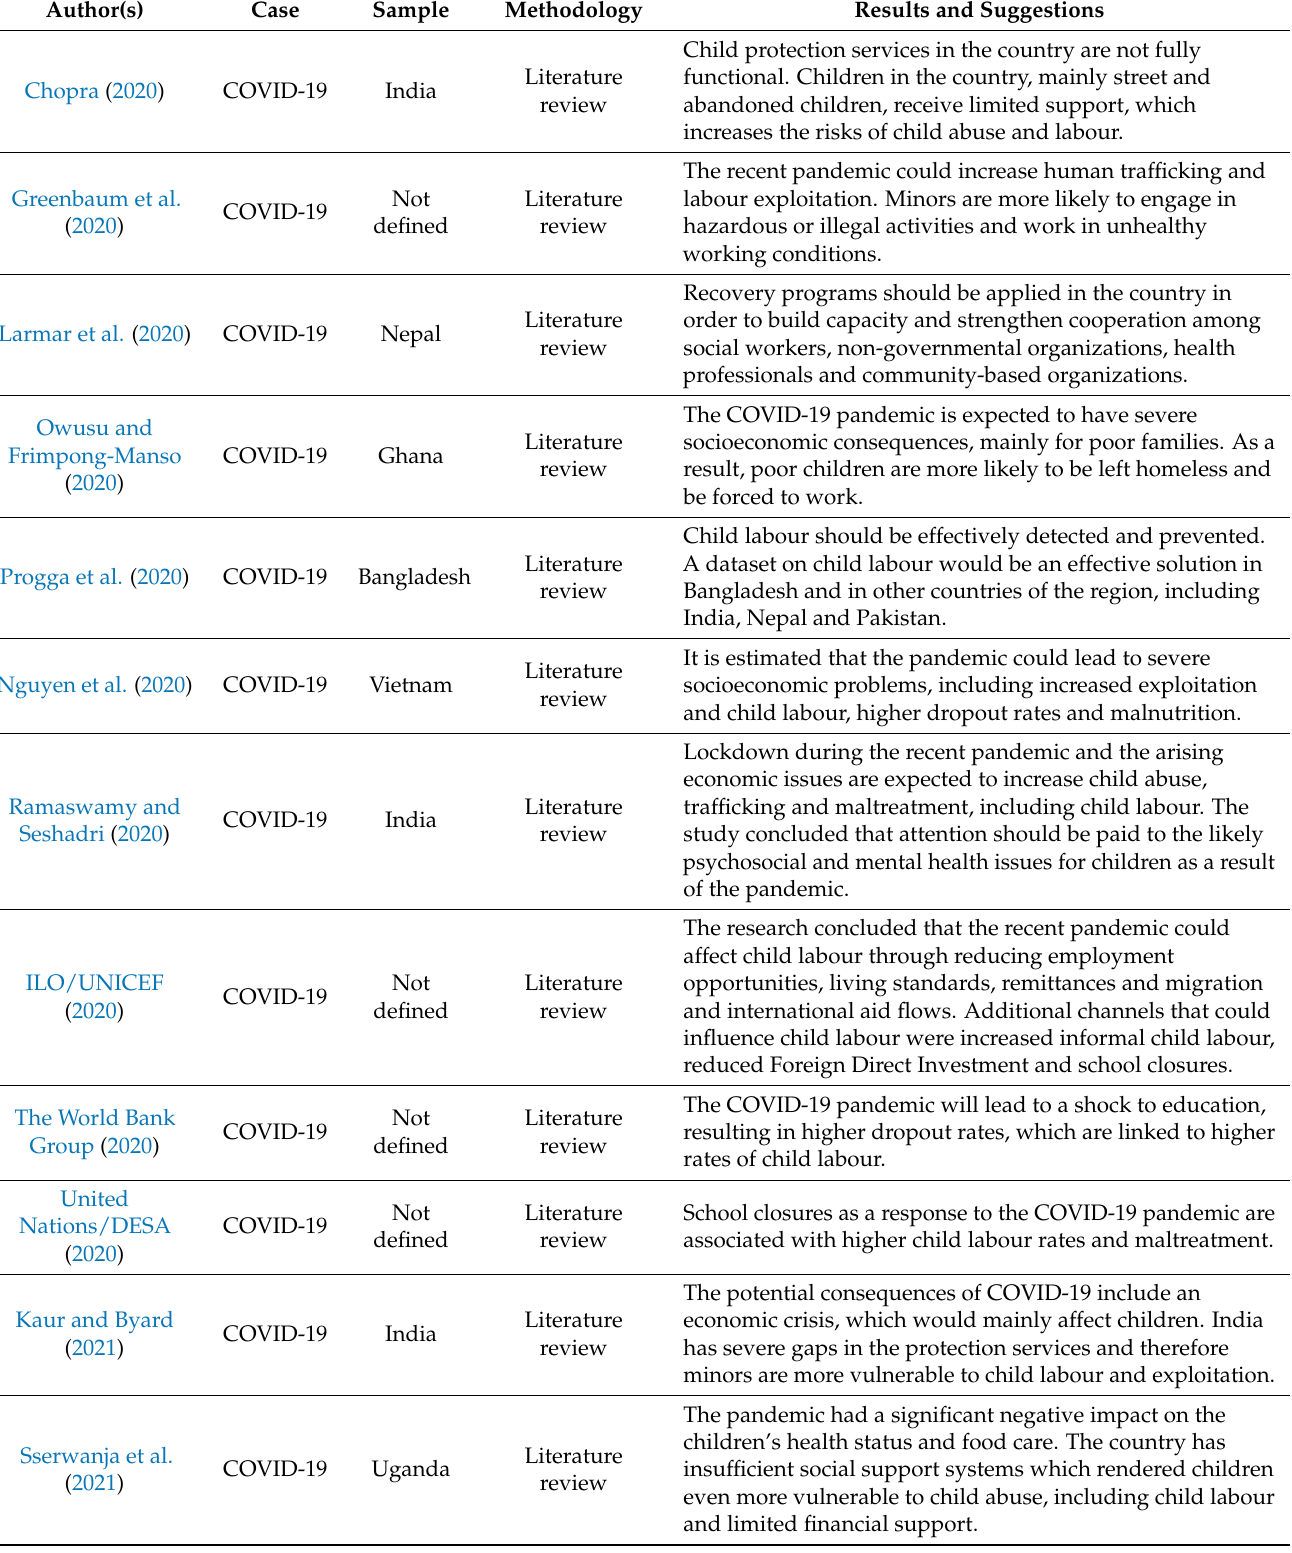
Table 3. Studies on child labour and COVID-19 (developing